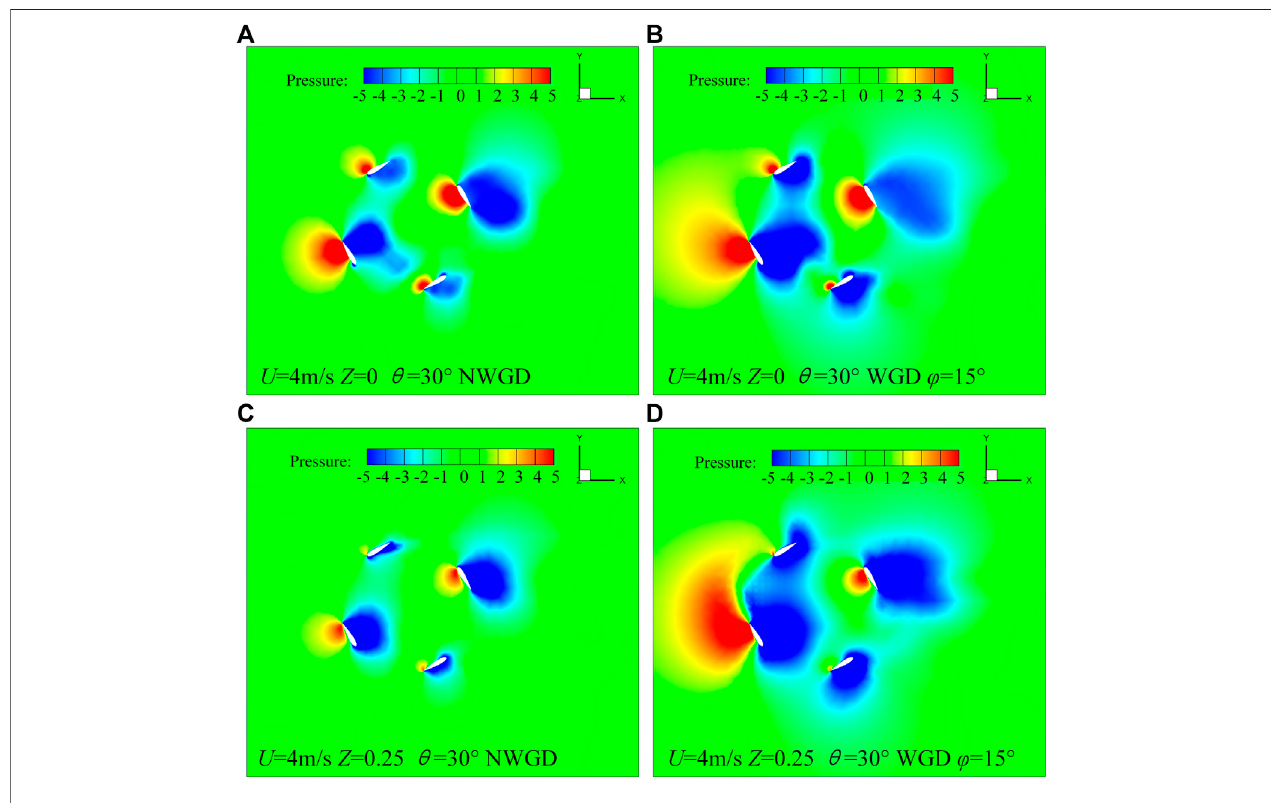
FIGURE 8 | Static pressure distribution at θ = 30 °